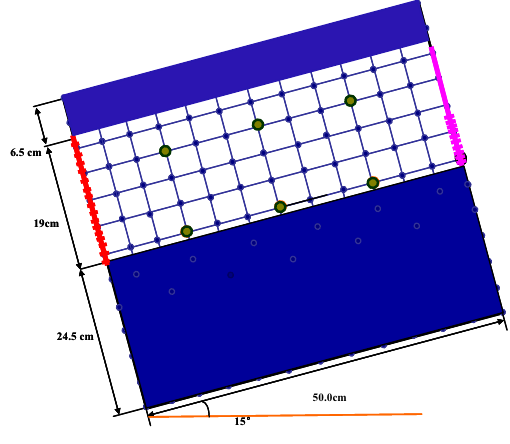
Fig. 2 The layout of injector, producer, PMPs and TMPs in the model